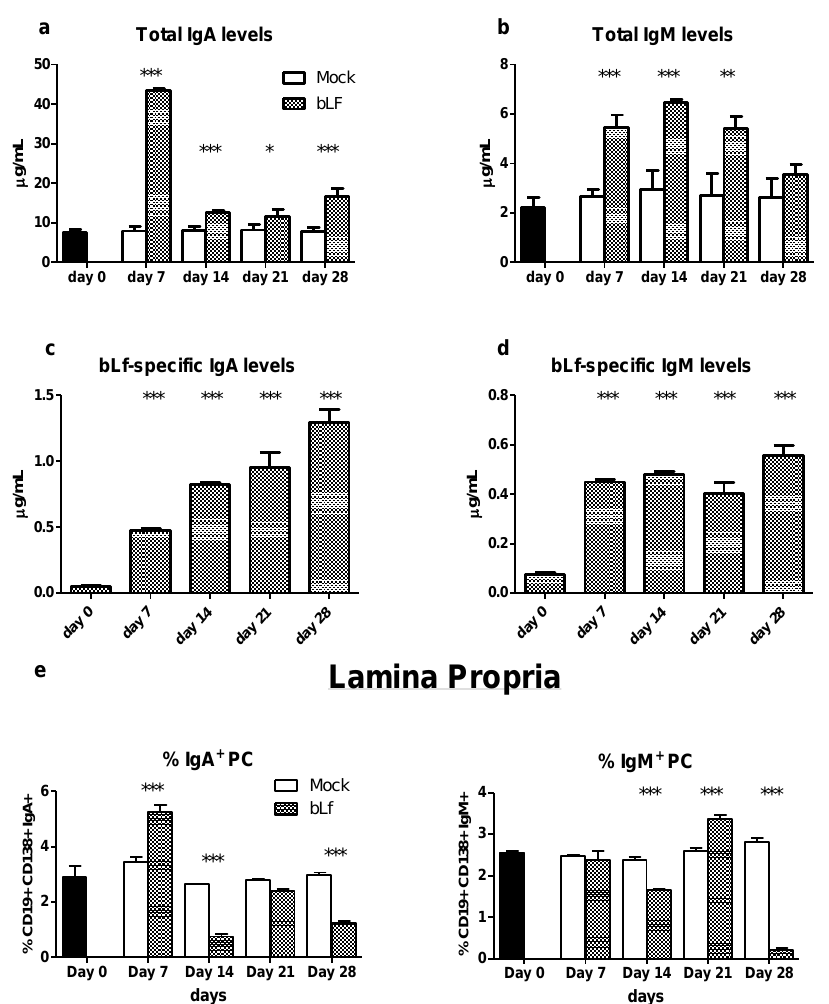
Figure 1. Effects of oral bLf vs. mock on the levels of total IgM ( a ) and IgM ( b ), and bLf-specific IgA ( c ) and IgM ( d ) in the intestinal secretions of the proximal small intestine. Mean and standard deviation (SD) are shown. Effects of oral bLf on the percentages of IgA + and IgM + plasma cells (PC)in lamina propria (LP) ( e ) of the proximal small intestine. Mean and SD are shown. Significant differences: * p ≤ 0.05, ** p ≤ 0.01, *** p ≤ 0.001, compared to mock in ( a , b , e ). Significant difference to day 0 is shown in 1( c , d ). Non-significant results are omitted.